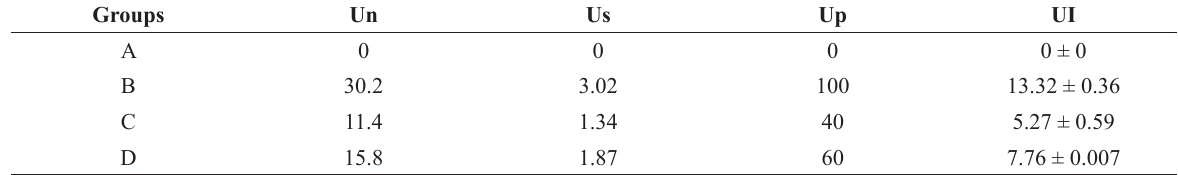
Calculation of Ulcer index (UI) from negative control (group A), positive control (group B), standard drug control (group C) and extract treated group of rats (group D) (* P <0.05; n=5). (Un: average number of uclers per animal, Us: average number of severity of scores, Up: percentage of animals with ulcers , UI: ulcer index).